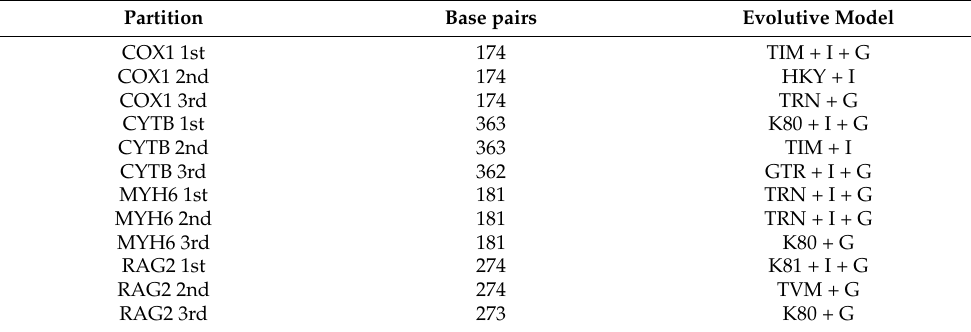
Table A2. Best-fitting partition schemes and evolutive